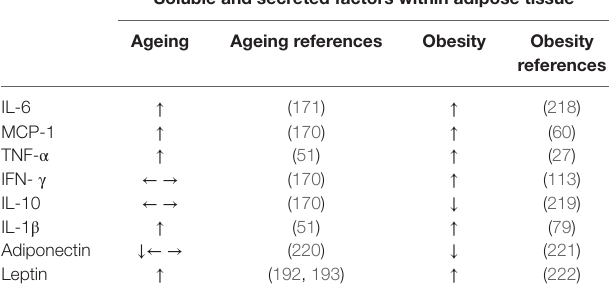
necrosis factor- α .